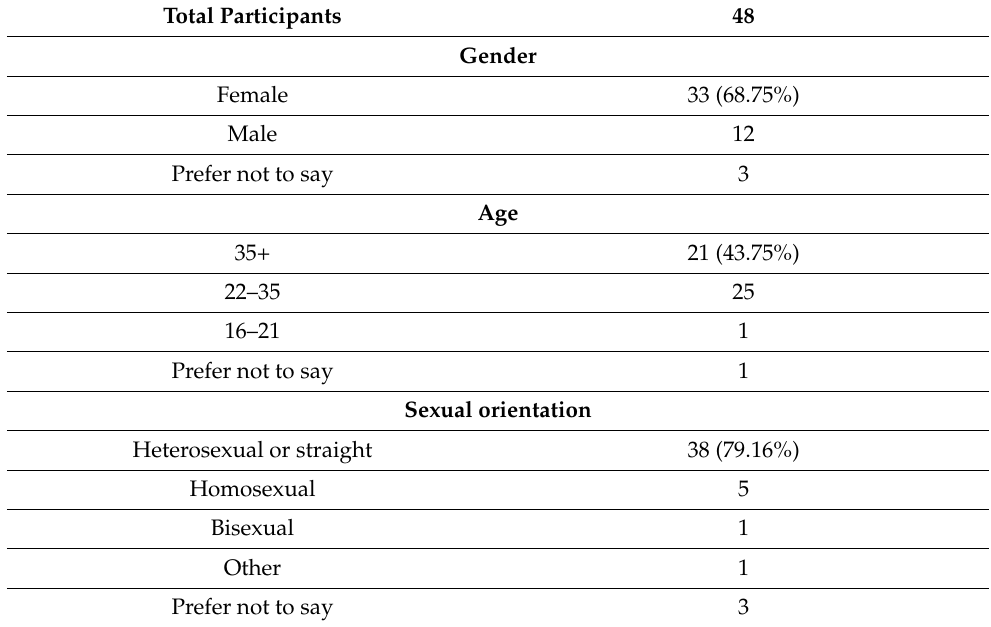
Table 2. Survey participant